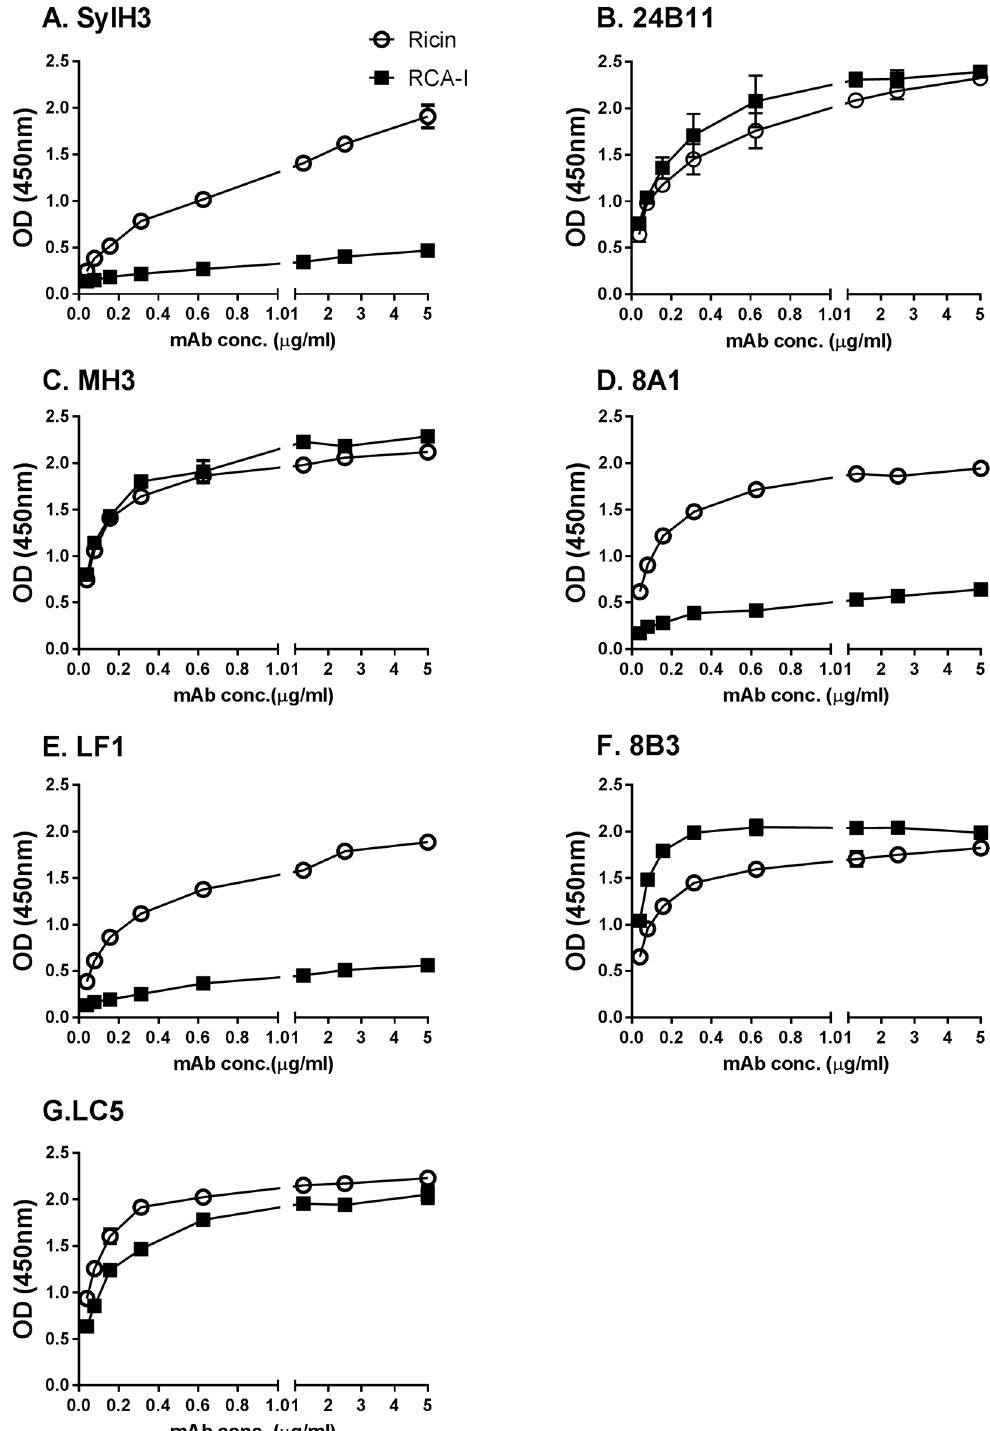
Fig 4. Differential reactivity anti-RTB mAbs with ricin and RCA-I. (Panels A-F) Ninety-sixwell microtiter plates were coated with 1 μ g/ml ricin (open symbols) or RCA-I (closed symbols) and probedwith indicatedmAbs at the concentrations shown on the x-axis. The data (mean ± SD) shown representa single experiment in which each sample was done in replicateand repeatedat least three times. The SD may be too small to visualizein the figure.